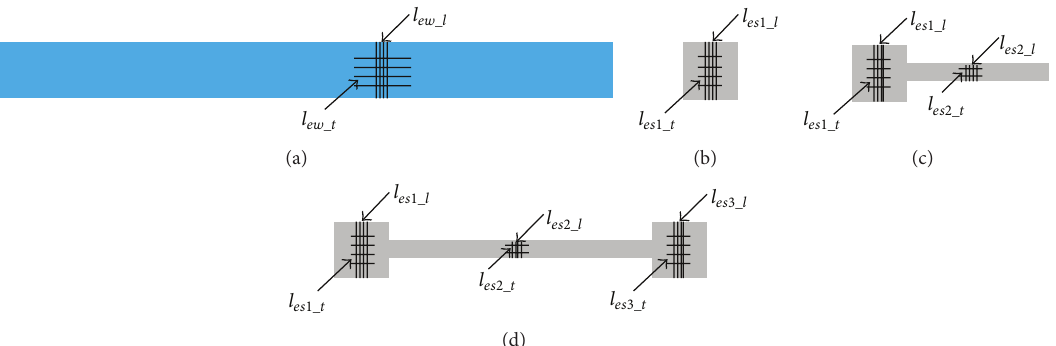
Figure 10: The mesh of fluid and structure: (a) the water column; (b) the panel with stiffener (T-shaped); (c) the panel with girder (I-shaped).